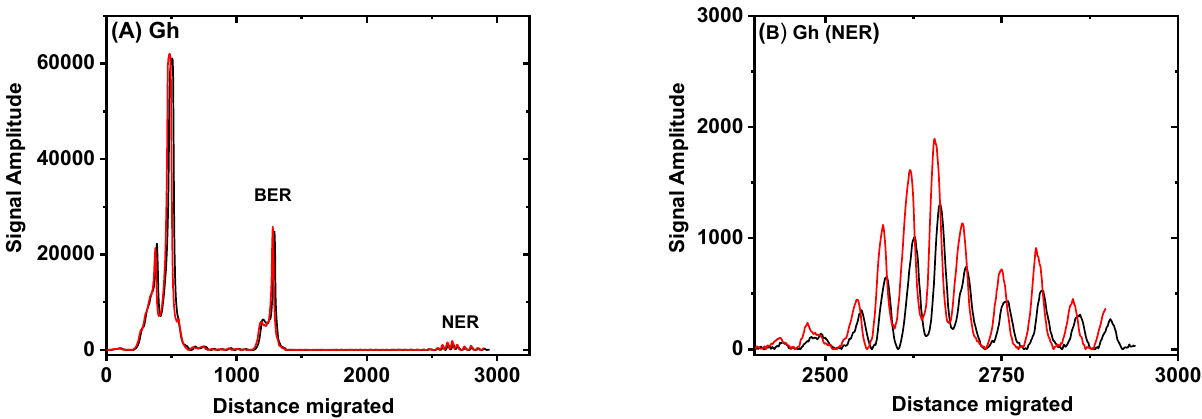
Figure 3. Gh sample , DNA repair product excision profiles: Gh lesion in 147-mer duplexes. Red lines: incubation in extracts from BRBE-treated HeLa cells; black lines: extracts from untreated cells. Densitometry scans of the 30 min incubation time lane in Figure 2. Panel ( A ): Trace of the entire lane, from the top to the bottom of the gel. Panel ( B ): Amplification ( × 20) of the lower region of the same lane showing the relative amplitudes of the ~24–30 nt oligonucleotide NER excision products.